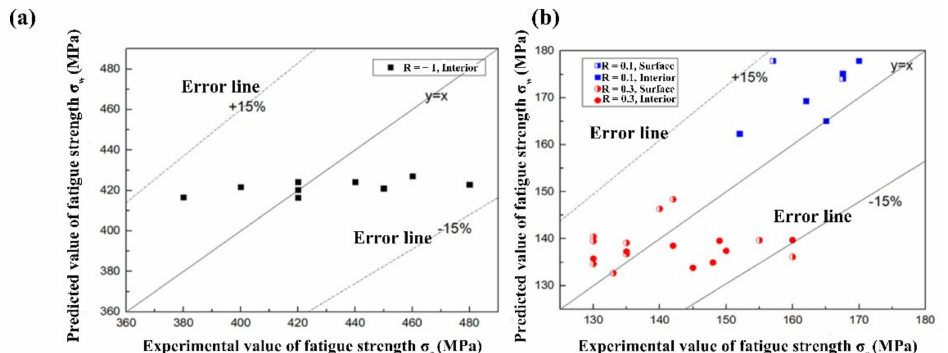
Figure 11. Comparison between the predicted value and experimental value of fatigue strength ( a ) R = − 1, ( b ) R >